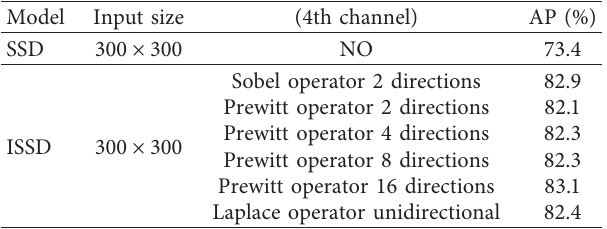
Table 1: Performance of sea urchin recognition under different test models with or without feature